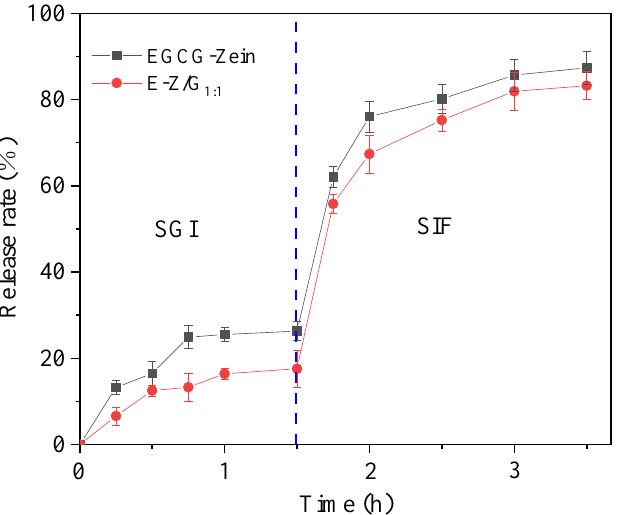
Figure 8. The cumulative release rate of EGCG in simulated gastric fluid (SGF) and simulated intestinal fluid (SIF).